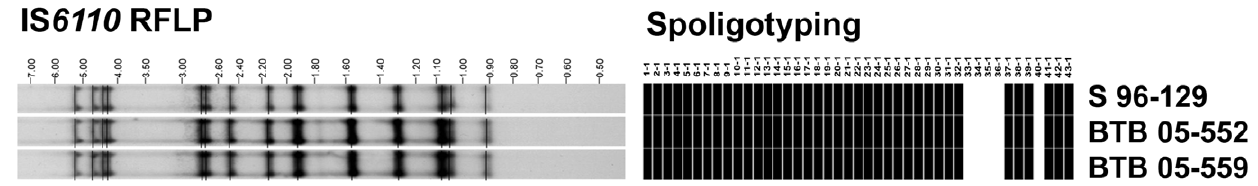
Figure 2. Stability in IS 6110 RFLP and spoligotyping patterns. IS 6110 RFLP and spoligotyping patterns of the three SMI-049 isolates S96-129, BTB 05-552 and BTB 05-559. Approximate molecular weights are indicated in kilo base pairs next to the RFLP gel picture. Spoligotype products 1–43 are depicted as black (positive) and white (negative) boxes.